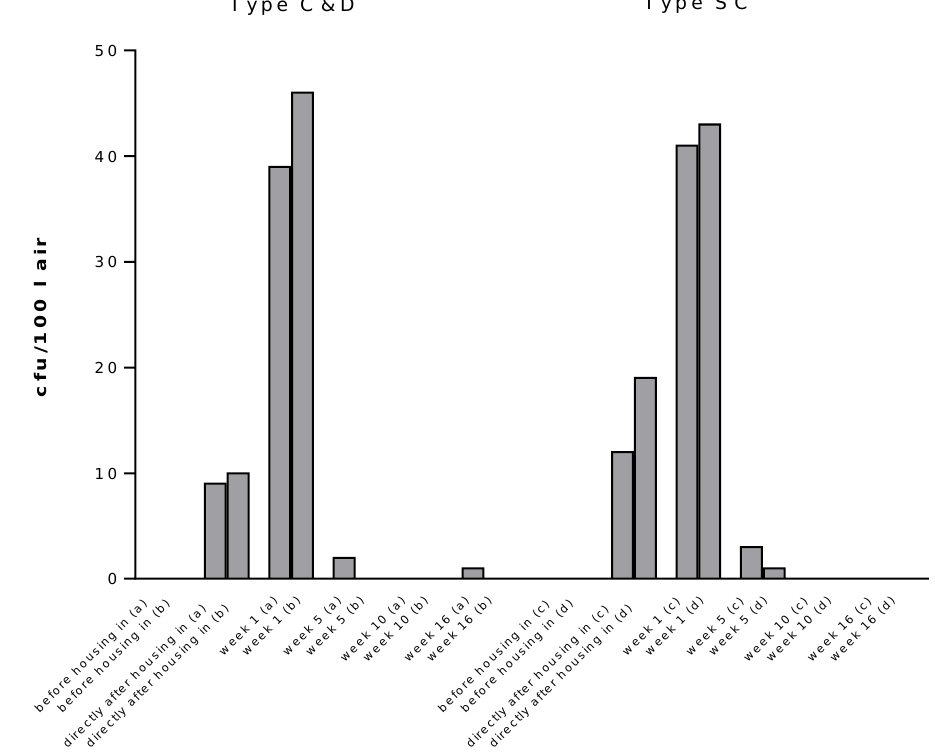
Figure 3. Collected air samples during fattening phase. Samples were collected at two different points inside the stables (front and back) at described time points. a and c (front and back samples, respectively, type C&D); b and d (front and back samples, respectively, type SC). The corresponding sample locations are shown comparatively.